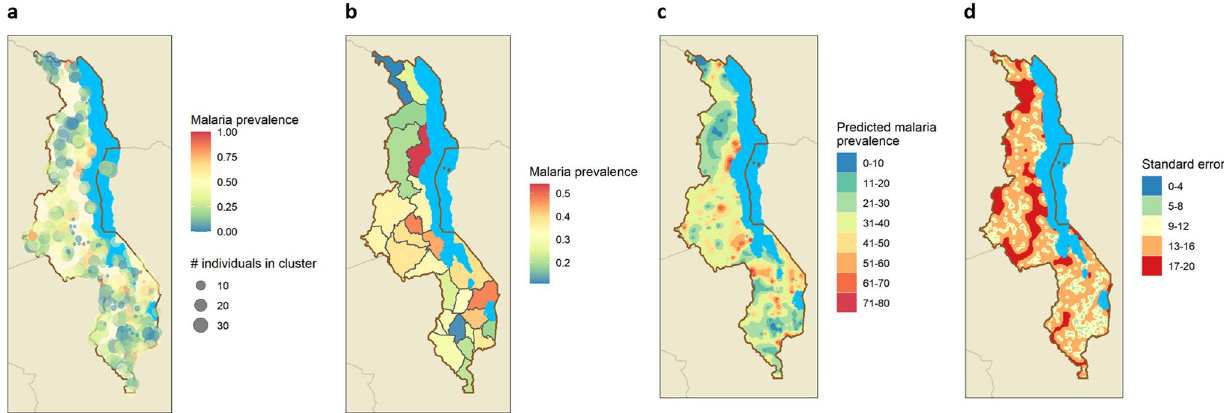
Figure 2. Spatial distribution of 2015–2016 MDHS clusters. ( a ) P. falciparum prevalence by cluster and cluster size, ( b ) weighted P. falciparum prevalence by district, ( c ) smoothed PCR P. falciparum prevalence estimates using simple kriging, ( d ) smoothed P. falciparum standard error estimates using simple kriging. Clusters with fewer than five observations were removed prior to kriging to reduce the influence of extreme values due to small sample sizes. Smoothed surfaces are meant to demonstrate regional differences and should not be used for interpretation into areas where data do not exist. All maps were run using R 3.5.1 (R Foundation for Statistical Computing, Vienna, Austria) and the sf ( v0.9–2 ; Pebesma, 2020)